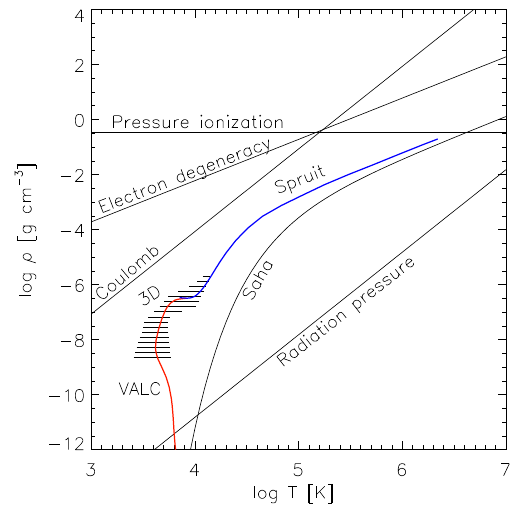
Figure 1. The boundaries in the T – ρ plane at which different non- ideal effects start to be significant. The boundaries are estimated for the case of the pure hydrogen plasma (after Hansen et al., 2004). The T – ρ dependency of the 1-D models of the solar atmosphere (VALC model, red curve) and of the solar convection zone (after Spruit (1974), blue) is indicated. The shaded area shows the portion of the T – ρ plane occupied by a typical snapshot from a 3-D HD